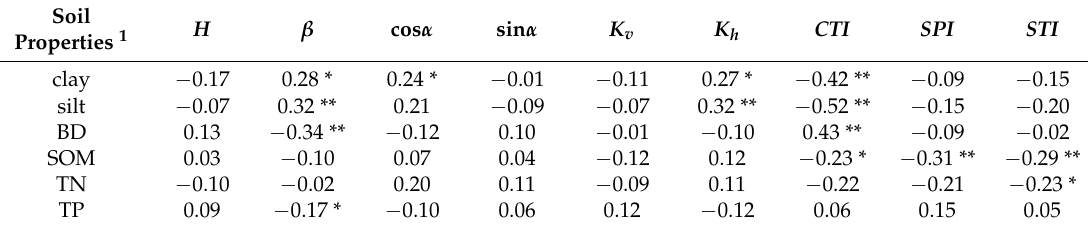
Table 5. Correlation matrix of soil properties and terrain